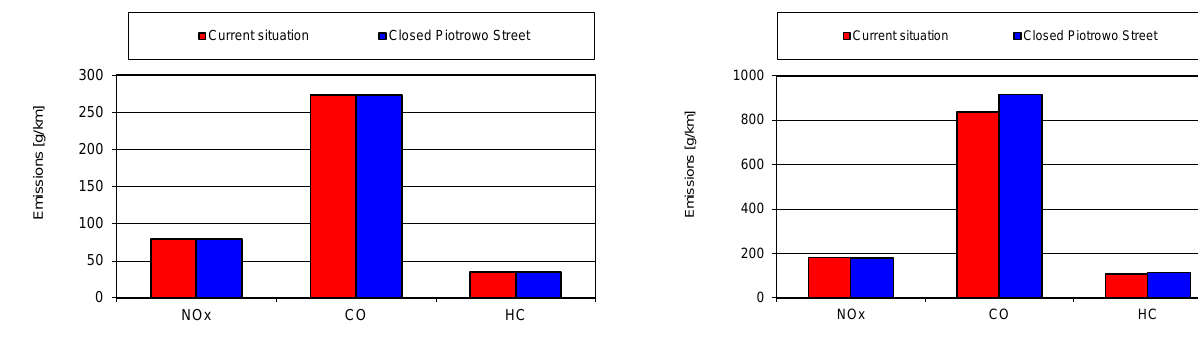
Fig. 4. Average vehicle emissions on the streets of Poznań in the afternoon Fig. 5. Average vehicle emissions in the area directly adjacent to the rush hours Poznań University of Technology at Piotrowo Street in the afternoon